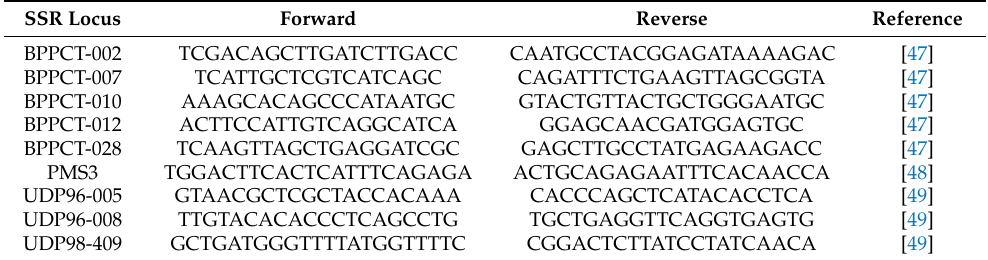
Table 1. SSR loci analyzed in this